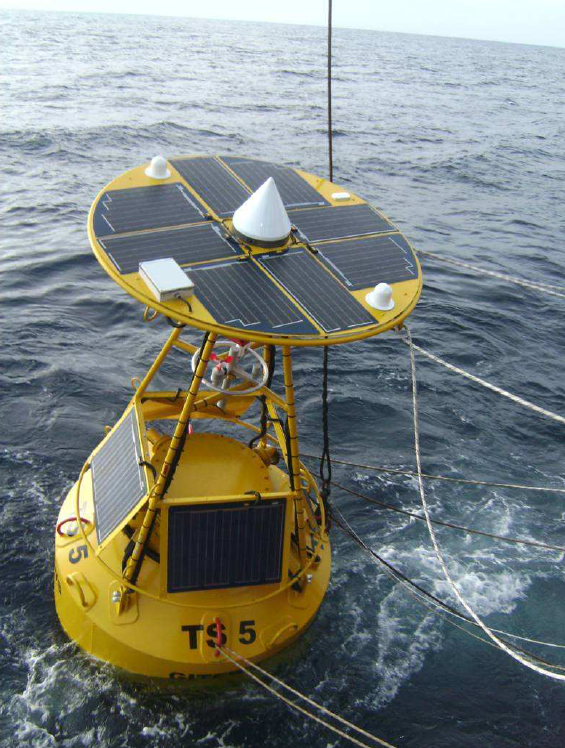
Figure 2b: GITEWS buoy TS5 during deployment operation. At the top ring the GPS antenna 2 Fig. 2b. GITEWS buoy TS5 during deployment operation. On (middle) is surrounded by the different communication antennas (BGAN, Iridium, PASTI). 3 the top ring the GPS antenna (middle) is surrounded by the The meteorological sensor arm is mounted inside the tower. Solar panels provide power for 4 different communication antennas (BGAN, Iridium, PASTI). The meteorological sensor arm is mounted inside the tower. Solar panels an uninterrupted operation. 5 provide power for uninterrupted